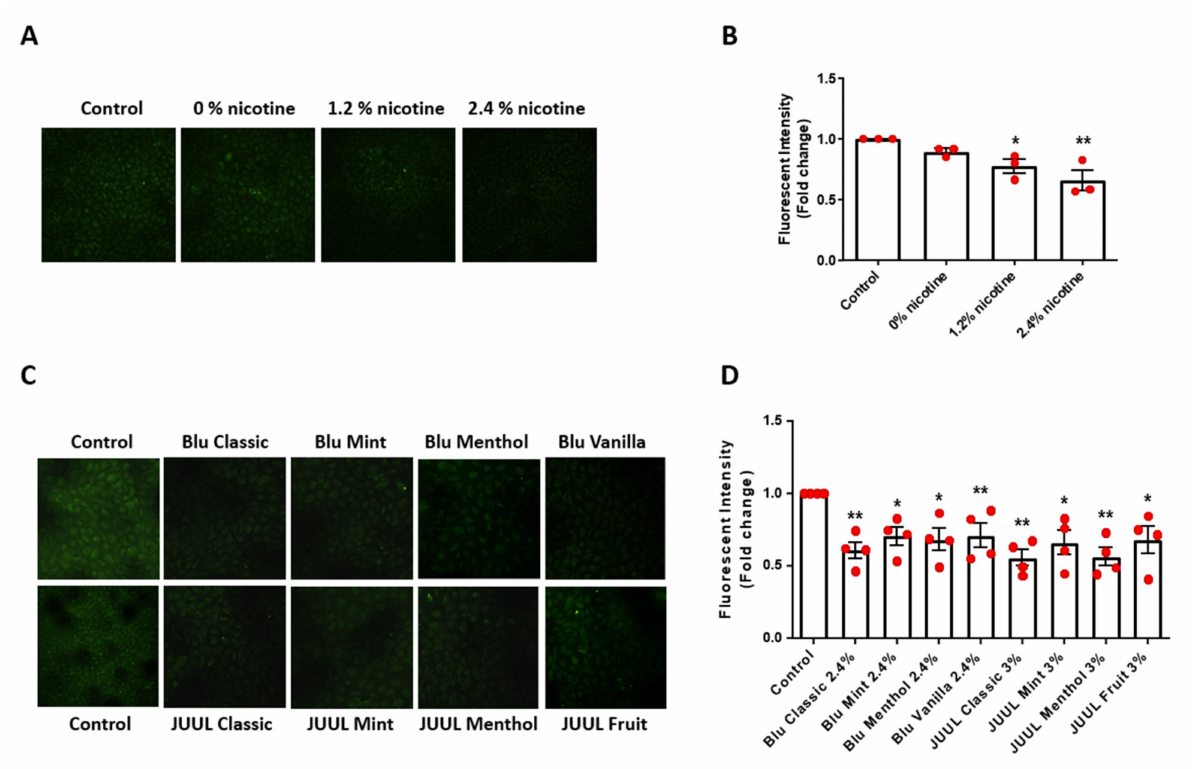
Figure 2. Nicotine-containing and flavored e-cigarettes decrease endothelial NO bioavailability. Confluent bovine aortic endothelial cells (BAECs) were starved overnight and incubated with e- cigarette smoke extract (e-CSE) for 24 h. e-CSEs were prepared from e-cigarette Gold leaf (Blu) at nicotine levels of 0%, 1.2%, and 2.4%, and flavored e-cigarettes (Blu: Classic, Mint, Menthol, and Vanilla, all with 2.4% nicotine levels; and JUUL: Classic, Mint, Menthol, and Fruit, all with 3% nicotine levels). Cells were incubated with nitric oxide (NO)-specific fluorescent probe 4-amino- 5-methylamino-2 (cid:48) ,7 (cid:48) -difluorofluorescein diacetate (DAF-FM DA, 20 µ mol/L) for 1 h.